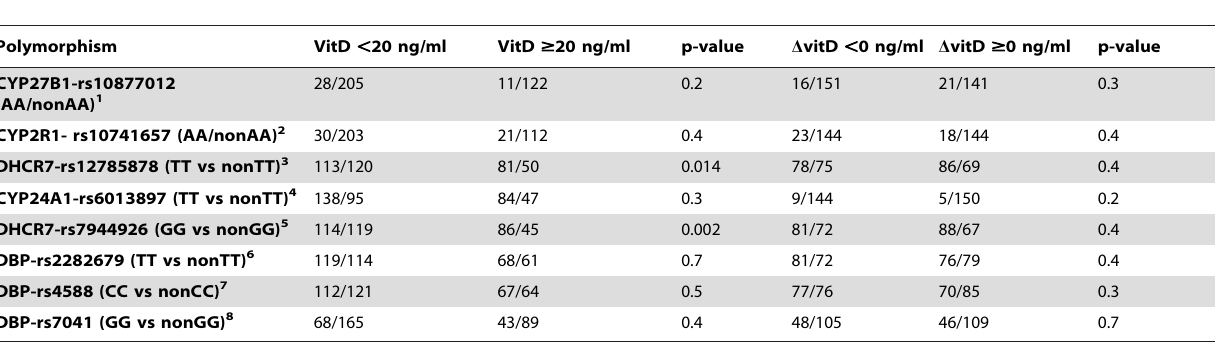
Table 3. SNP’s within VitD regulating enzymes in association with baseline VitD values and VitD variations ( D Vitd) upon antiviral therapy.